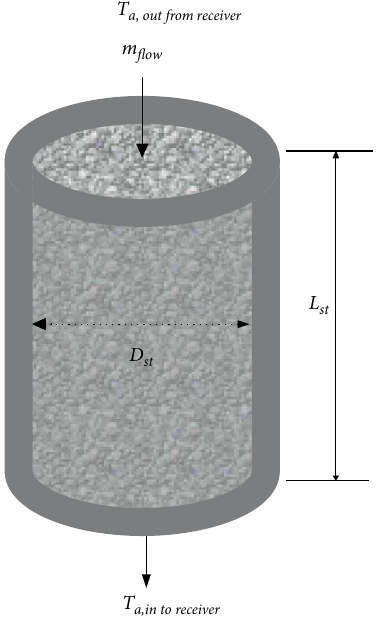
Figure 4: Schematic diagram of packed pebble bed storage